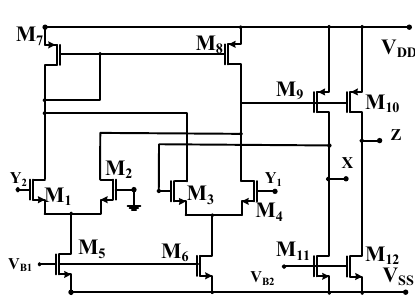
Figure 1. DVCC block diagram.